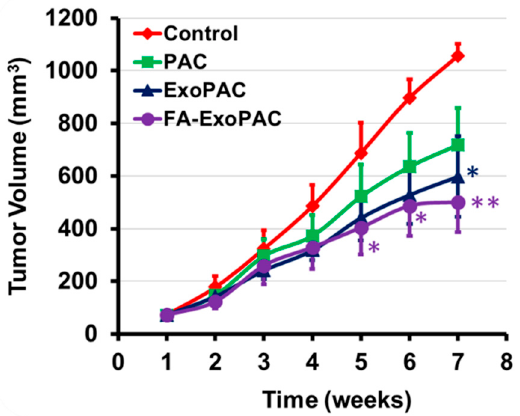
Figure 4. Antitumor activity against subcutaneous xenografts. Following inoculation with A549 cells, nude mice were treated with oral gavage three times a week with PAC (6 mg/kg bw), ExoPAC and FA-ExoPAC (6 mg PAC and 50 mg Exo protein/kg bw). Data represent average ± SD of means ( n = 8). Statistical analysis was performed using the Student’s t -test. * p < 0.05; ** p <